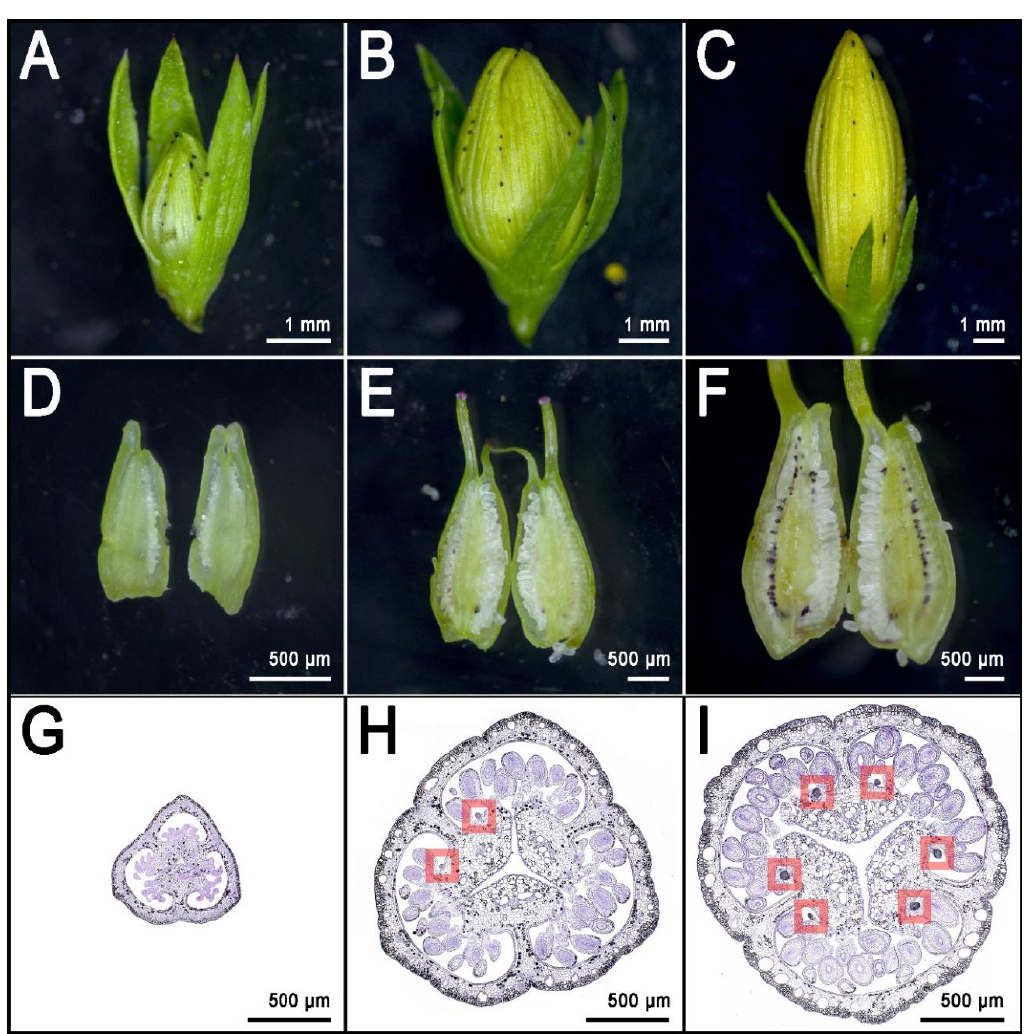
Figure 4. Multiple stages of flower development (upper row) with corresponding pistils shown as longitudinal sections (middle row) and thin transverse sections (lower row). ( A ): Flower bud of length 2.14 mm; ( B ): Flower bud of length 5.24 mm; ( C ): Flower bud of length 10.38 mm; ( D ): Longitudinally sectioned pistil from flower bud in photo A; ( E ): Longitudinally sectioned pistil from flower bud in photo B; ( F ): Longitudinally sectioned pistil from flower bud in photo C; ( G ): Transverse section of a pistil before the differentiation of dark glands. This stage is completely dark glands free; ( H ): Cross transverse section of a pistil right at the moment of the differentiation of dark glands from the placental tissues. Dark glands highlighted by red squares; ( I ): Transverse section of a pistil with well differentiated and growing placental dark glands. All 6 rows (2 per carpel) of dark glands are visible on the same section and highlighted by red squares. Photos by Paride Rizzo and Twan Rutten.